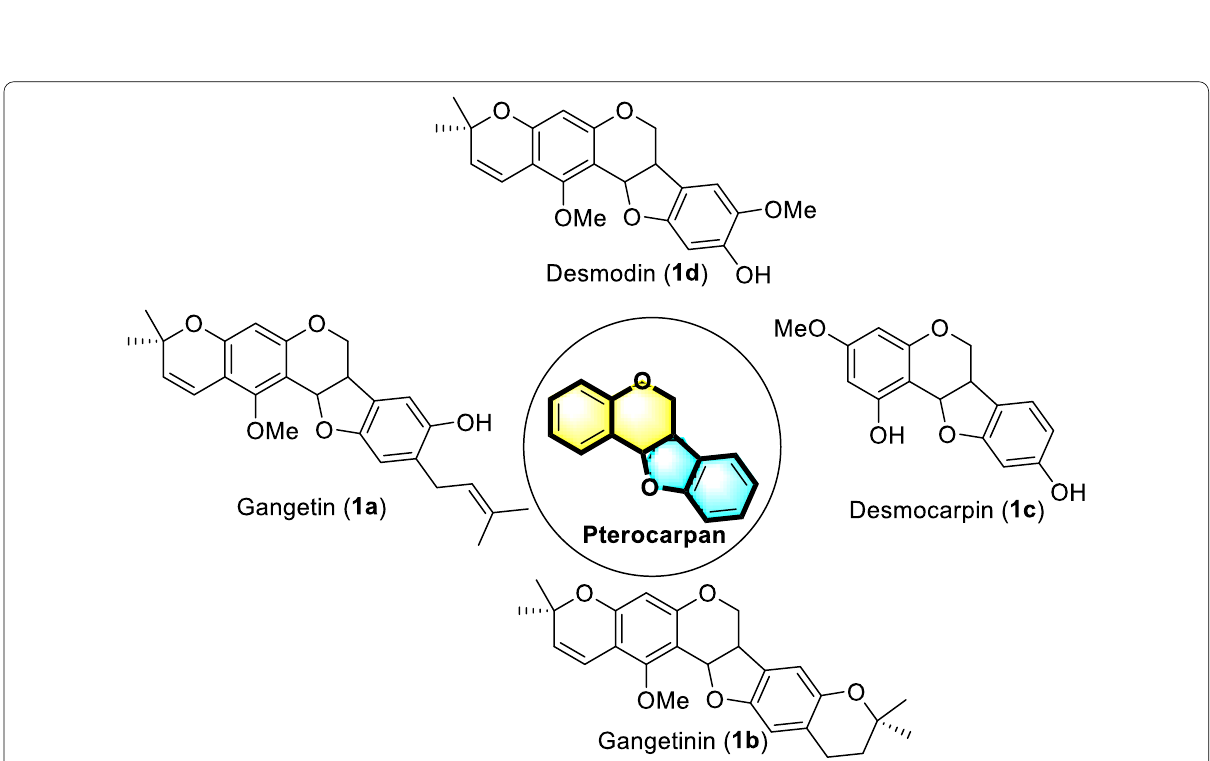
Fig. 5 Selected pterocarpan derivatives from D. gangeticum (L.)